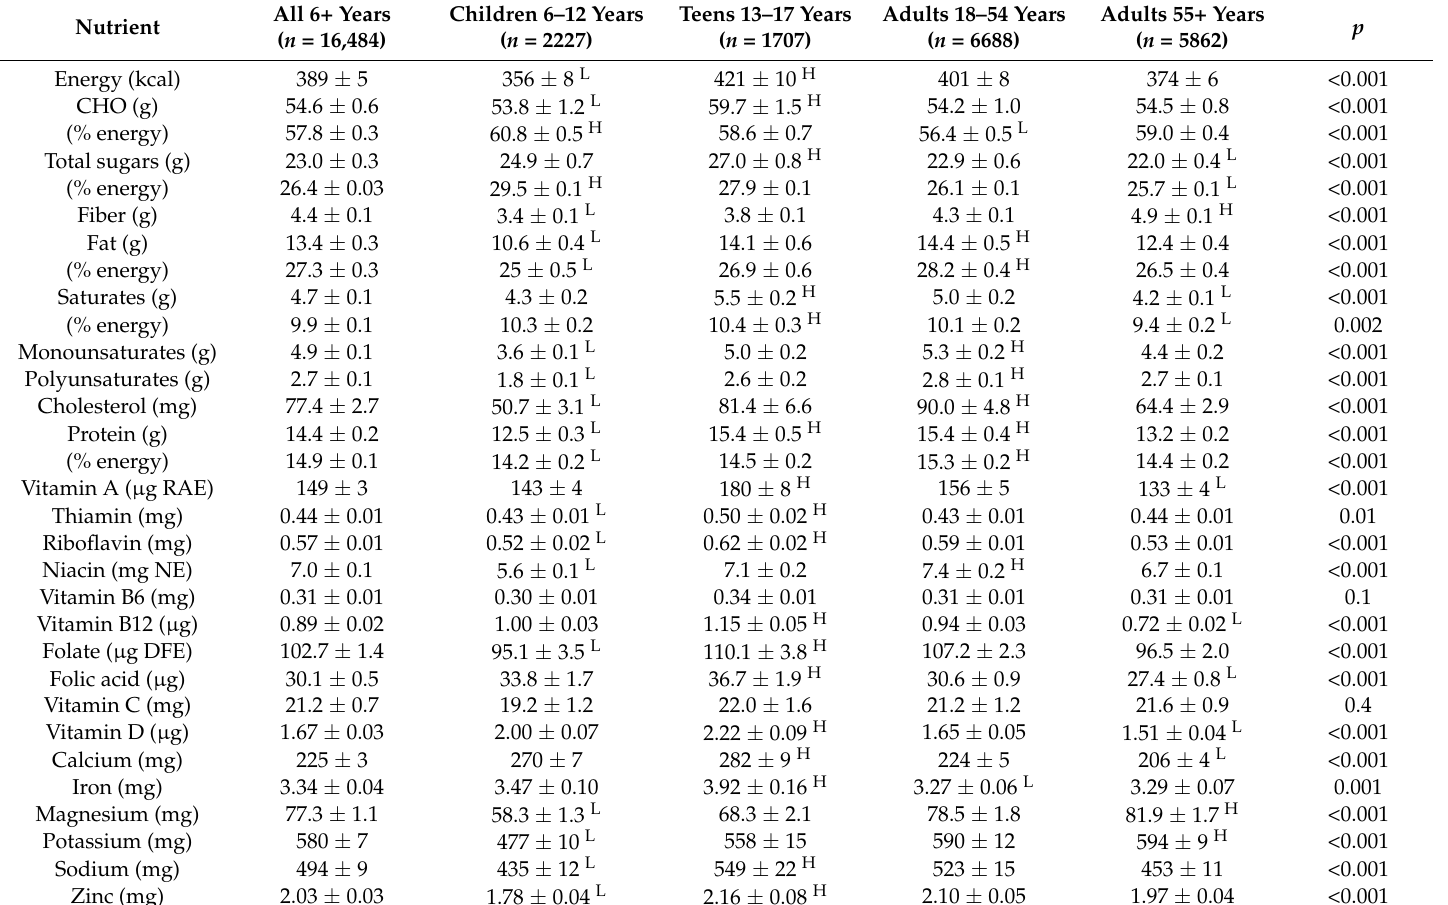
Table 3. Energy and nutrient intakes at breakfast among Canadian breakfast consumers 1